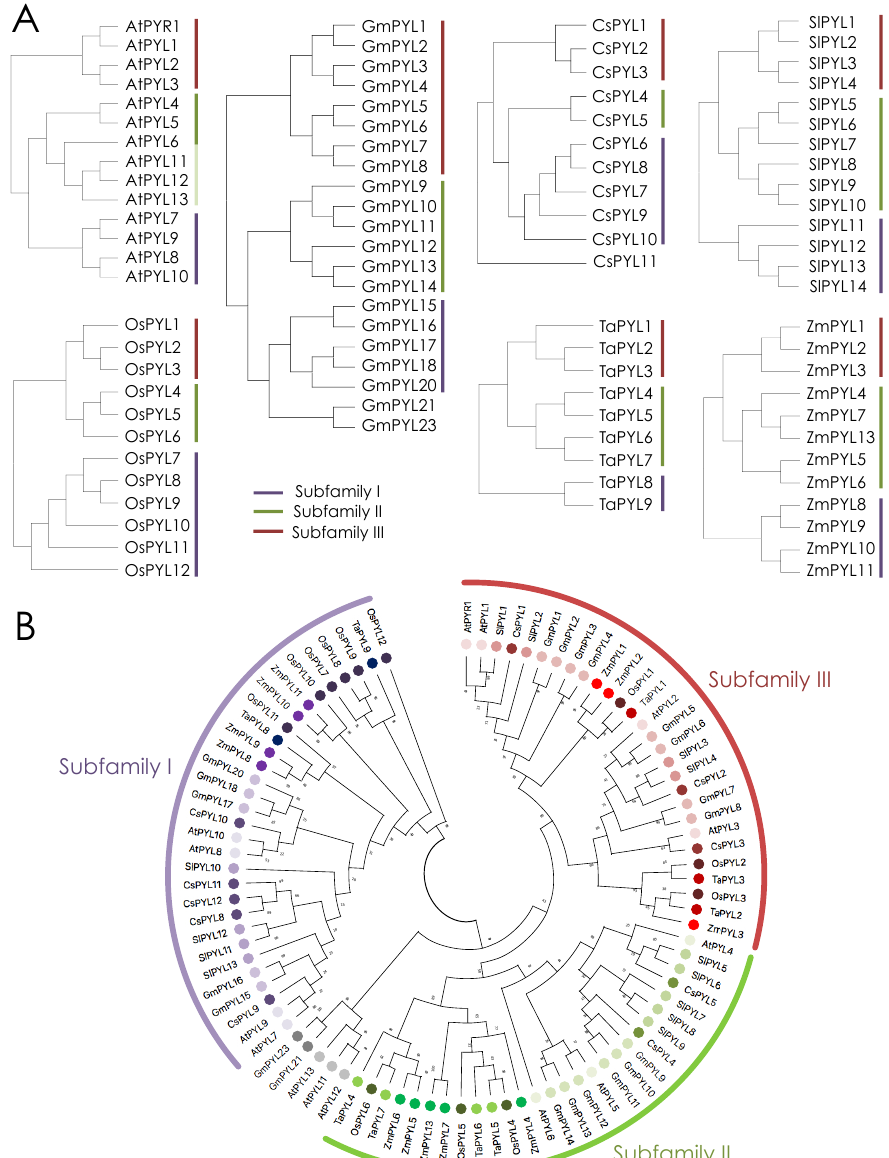
Figure 1. ABA receptors in different crops. Cladograms ( A ) and circular phylogenetic tree ( B ) of PYR/PYLs in eudicot and monocot food crops. Receptors are grouped in three different subfamilies: subfamily I (purple), subfamily II (green) and subfamily III (red). Cladograms and the circular phylogenetic tree were built with the maximum likelihood method. The phylogenetic tree was built using 1000 bootstraps in MEGA. Numbers indicate bootstrap